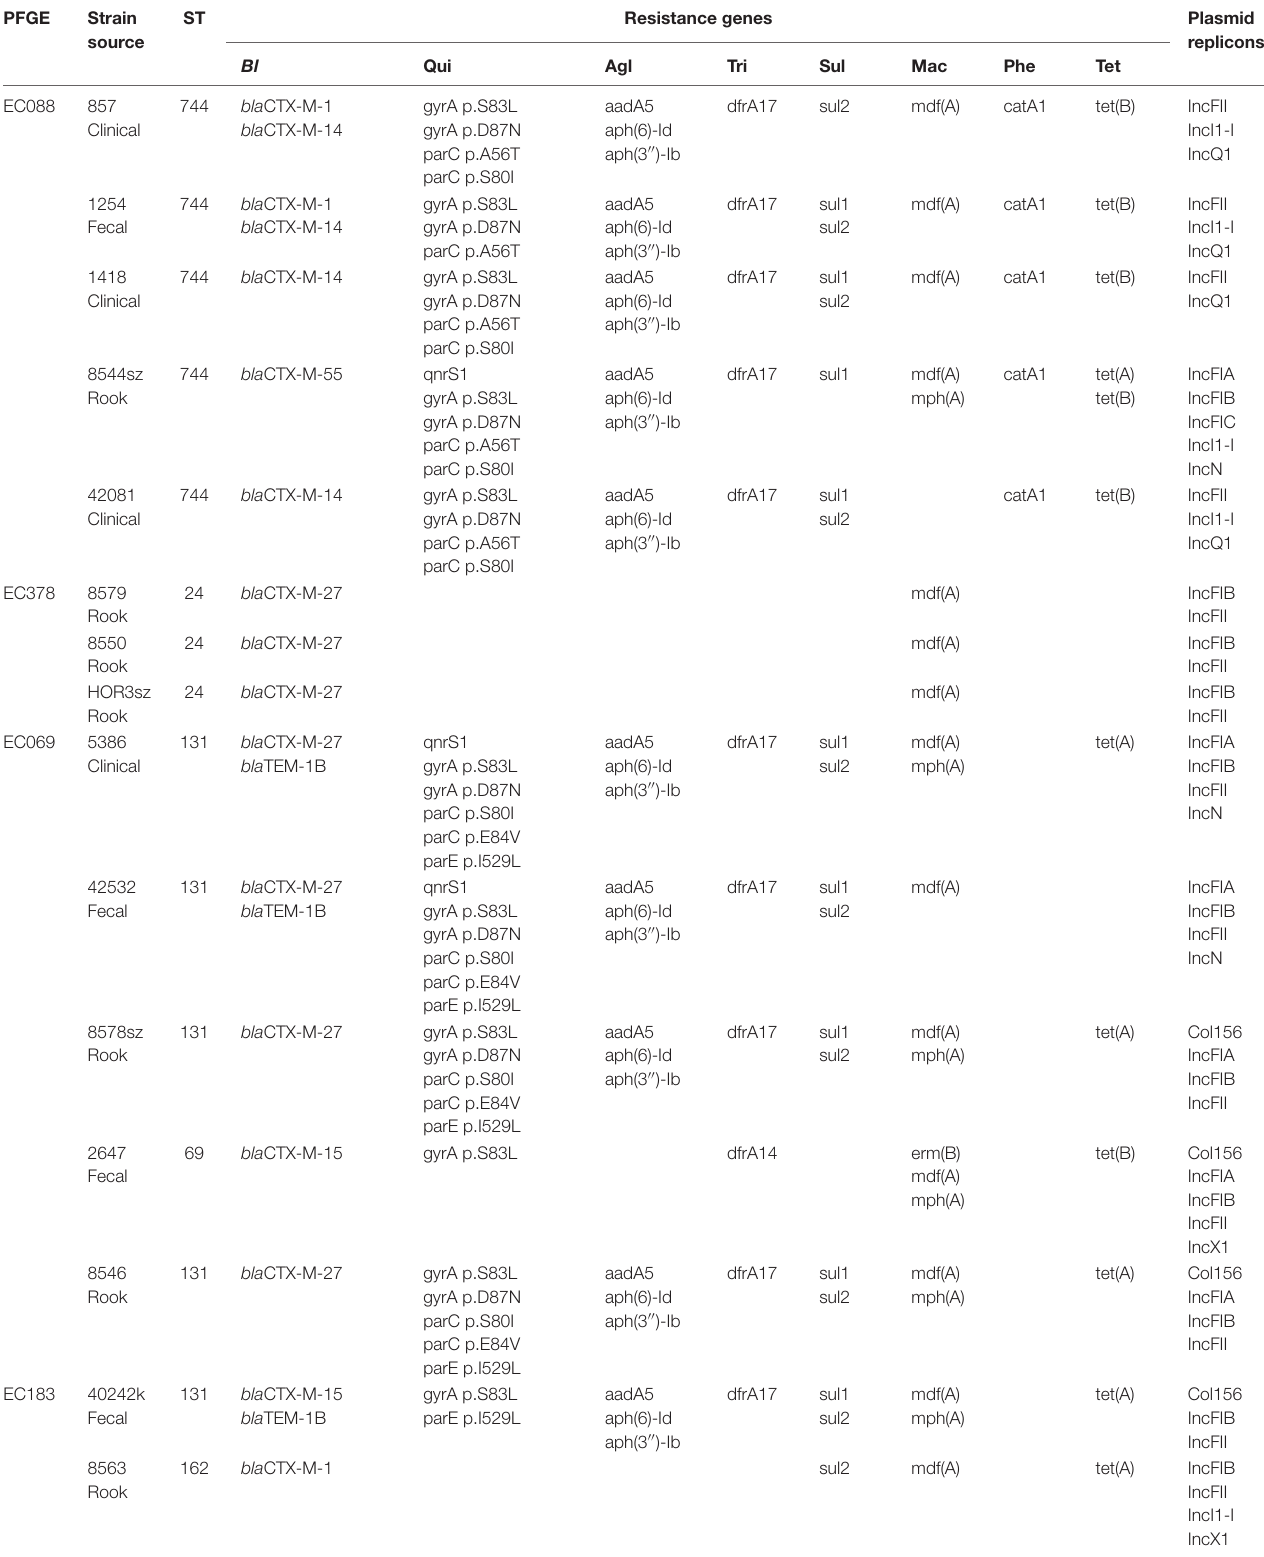
TABLE 1 | Results of whole genome sequencing of the selected isolates. PFGE Strain